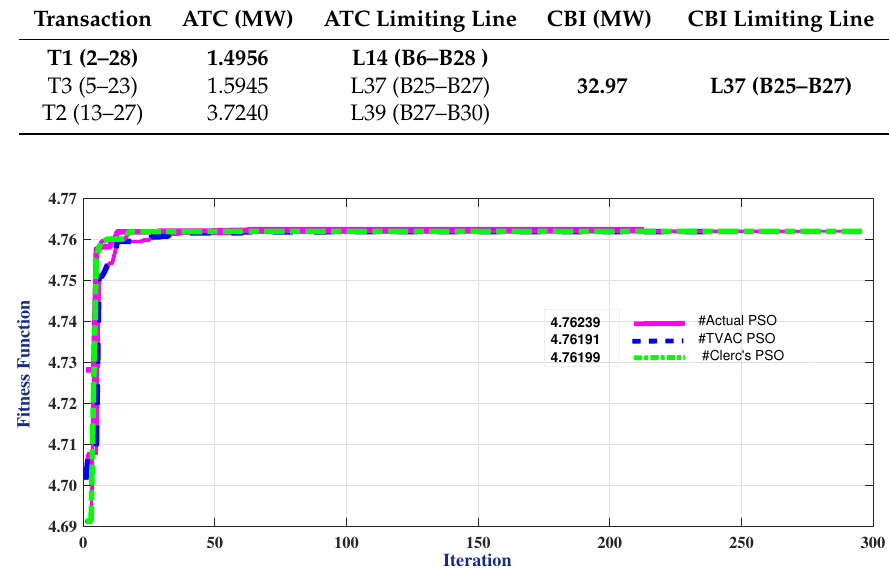
Figure 5. Convergence characteristics for T1: